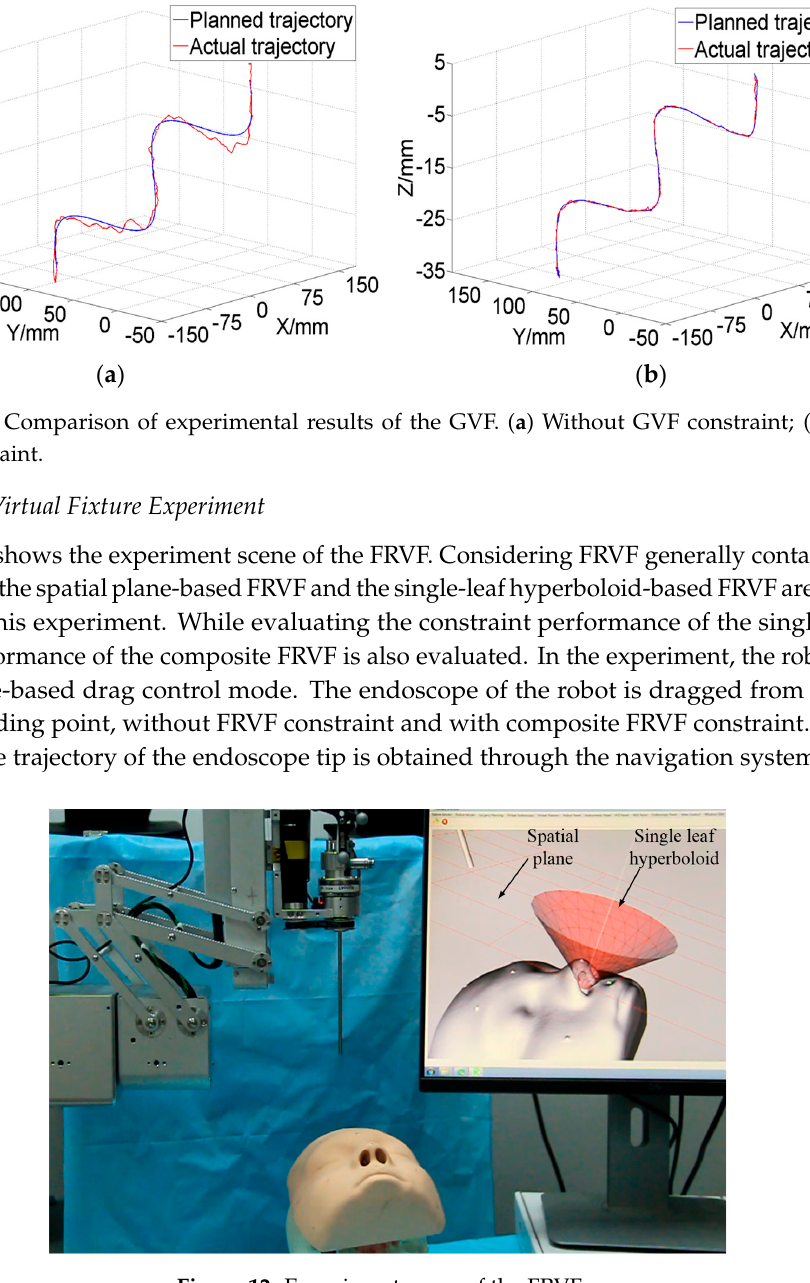
Figure 12. Experiment scene of the FRVFs.